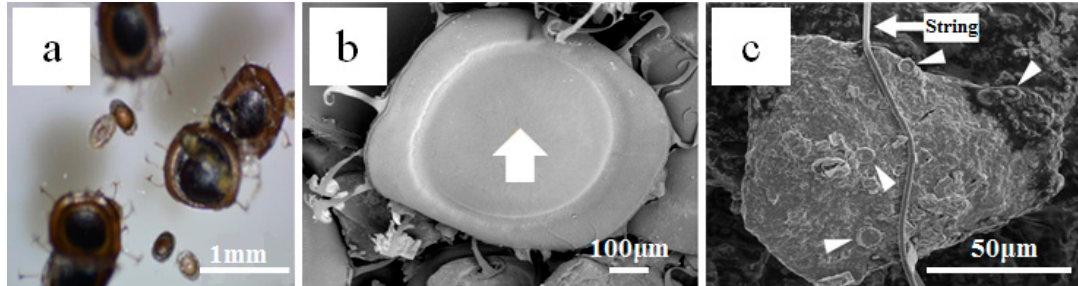
Figure 3. Optical micrographs of the statoblasts of Pectinatella magnifica ( a ) collected from Makiyama agricultural reservoir pond. Scanning electron microscope (SEM) micrograph of the statoblasts of P. magnifica ( b ) collected from Makiyama agricultural reservoir pond. SEM micrographs of massive colonies of Pectinatella magnifica , showing a long adherent string (( c ), an arrow) and four spherical Pectinatella magnifica on the surface of gelatinous material (( c ), four arrows).